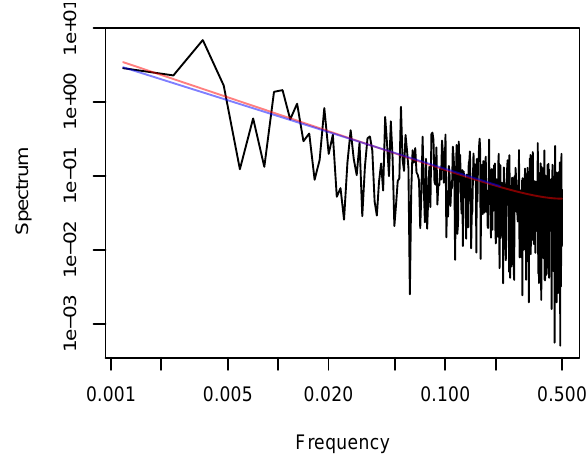
Fig. 2. Periodogram of the time series of Nile River minima (see Fig. 1), in log-log coordinates, including the straight line of the Geweke and Porter-Hudak (1983) (GPH) estimator (blue) and a fractionally differenced (FD) model (red). In both cases we obtain ˆ β = 0 . 76 and thus a Hurst exponent of ˆ H = 0 . 88 ; asymptotic standard deviations for ˆ β are 0 . 09 for the GPH estimate and 0 . 05 for the FD model.